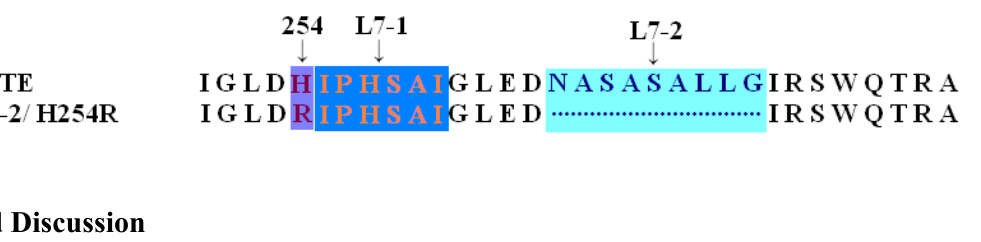
Figure 1. Sequence alignment between the WT PTE and